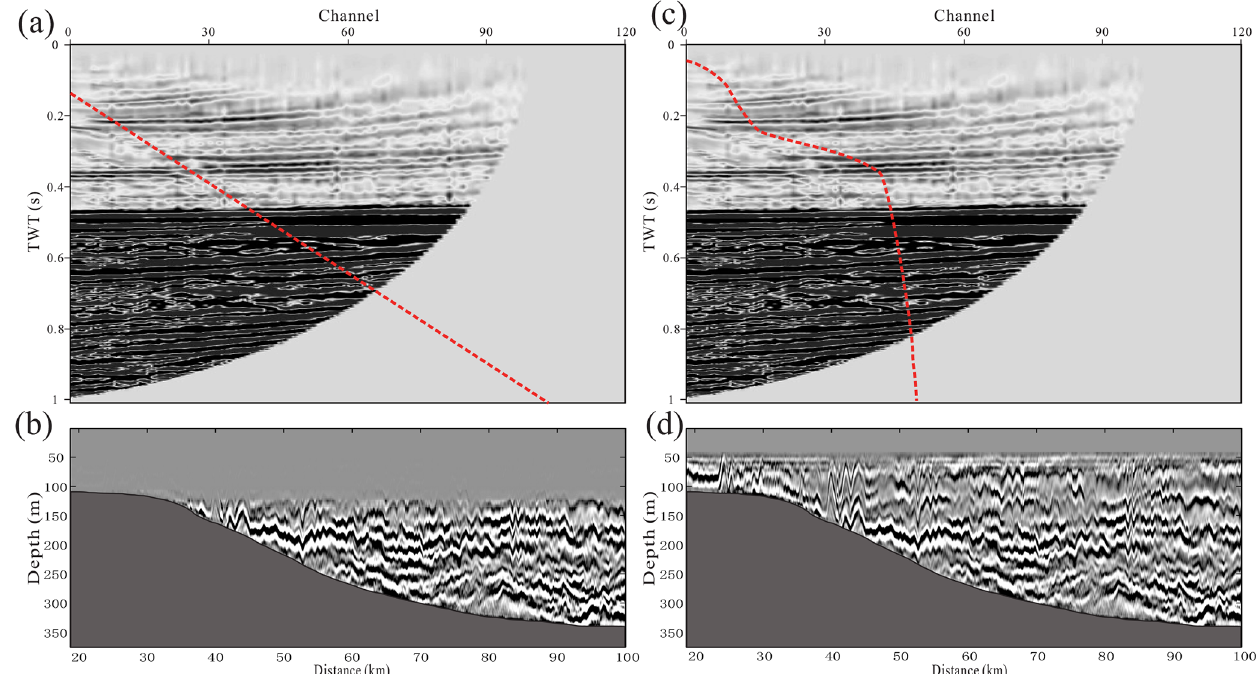
Figure 2. Cutting off the stretch of NMO with a linear function (a) and the corresponding seismic section (b) . Cutting off the stretch of NMO with a custom function (c) and the corresponding seismic section (d) . The red dotted line shows the cutoff trace; the right part of seismic data is cut off. The unit TWT of (a) and (b) is the two-way travel time of seismic wave from source to receiver.